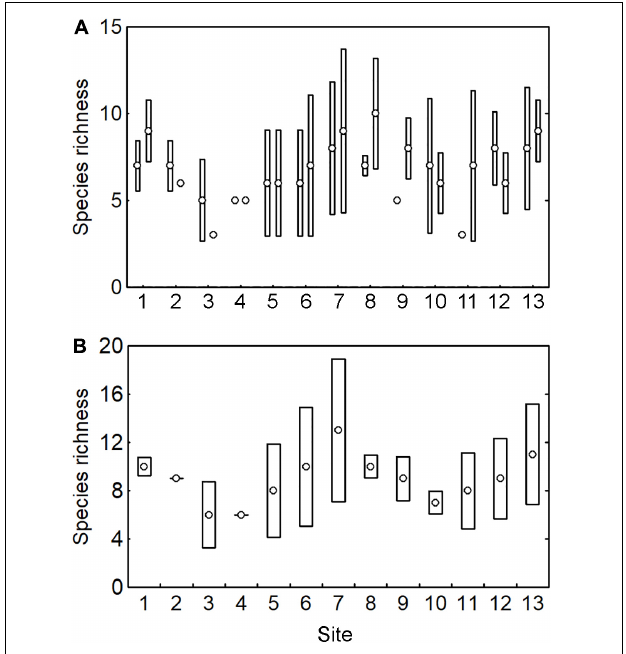
FIGURE 4 | Coral species richness (SR) across 13 sites with two sampling locations per site, including (A) SR at sampling location, and (B) SR at site. Circles indicate the observed SR and bars the 0.95 confidence interval. Those circles without bars indicate that SR was the same in all the pooled